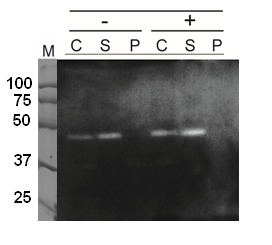
Expression of PsFDH[QN] in 
Anabaena
-fdh.

Anabaena
-fdh cells were cultured in non-inducible ((-), BG11) or inducible ((+), BG110) medium and their whole lysates (C), lysate supernatants (S) and lysate precipitates (P) were analyzed by Western blotting using anti-Histag antibody HRP conjugate. Chemiluminescent signals were detected at approximately 44 kDa as expected.